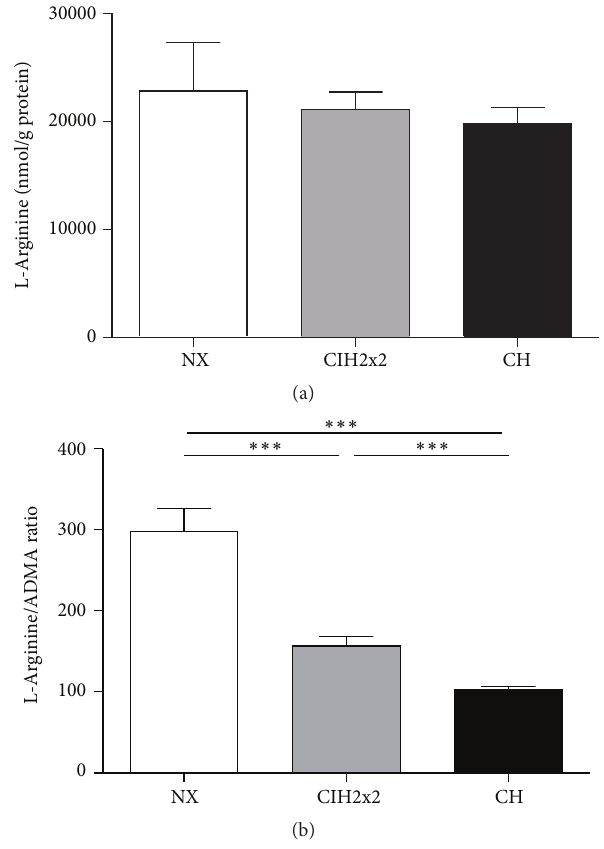
Figure 3: Comparison of (a) L-arginine levels (nmol/g protein) by mass spectrometry and (b) the L-arginine/ADMA ratio in the lungs of rats exposed to normoxia (NX), chronic intermittent hypoxia (CIH2x2), or chronic hypoxia (CH). Values are expressed as means and SE. ∗∗∗ 𝑝 < 0.001 ; 𝑛 = 8 in each